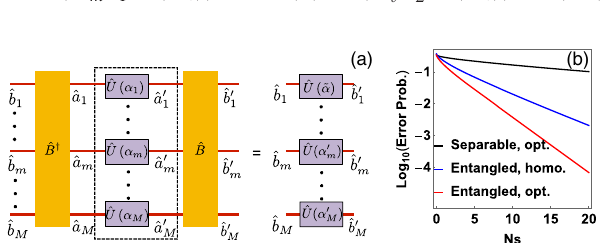
FIG. 8. (a) Interferometer structure for amplitude mixing in a distributed sensing scheme. (b) Performance of the symmetric 0 . 1 ; 1 ≤ m ≤ M case, M ¼ 10 and α m ¼